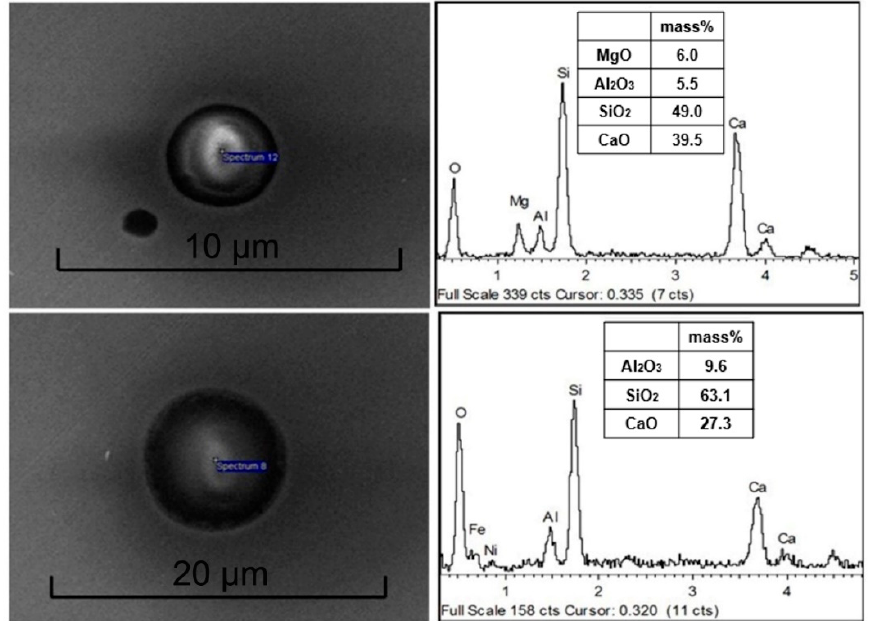
Figure 13. SEM images and EDS results of inclusions in casting slab in the case of calcium addition 2 m/t in LF.